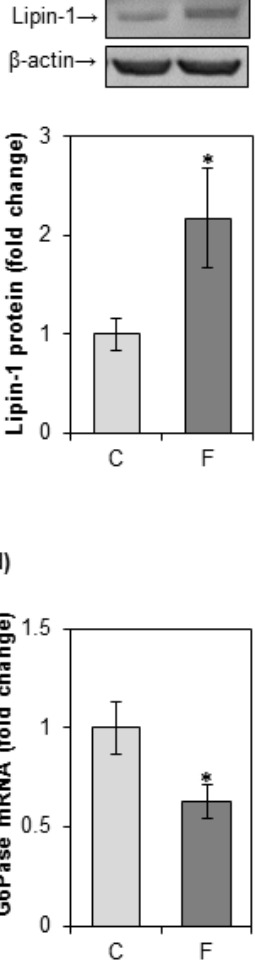
Figure 4. The e ff ects of a fructose-rich diet on the level of GR, lipin-1 PEPCK, and G6Pase in the liver. Groups: control (C), fructose-fed (F). ( a ) GR protein level in hepatic cytosols and nucleosols, and ( b ) lipin-1 protein level in hepatic whole cell extracts, were measured by Western blot. Relative integrated optical density of the immunoreactive bands was assessed by ImageQuant software, normalized to equal load controls and expressed as fold of the control. The levels of PEPCK ( c ) and G6Pase ( d ) mRNA were determined by qPCR and expressed as fold of the control. The values represent the means ± SEM ( n = 9). Statistical significance of differences between experimental groups: * p < 0.05.